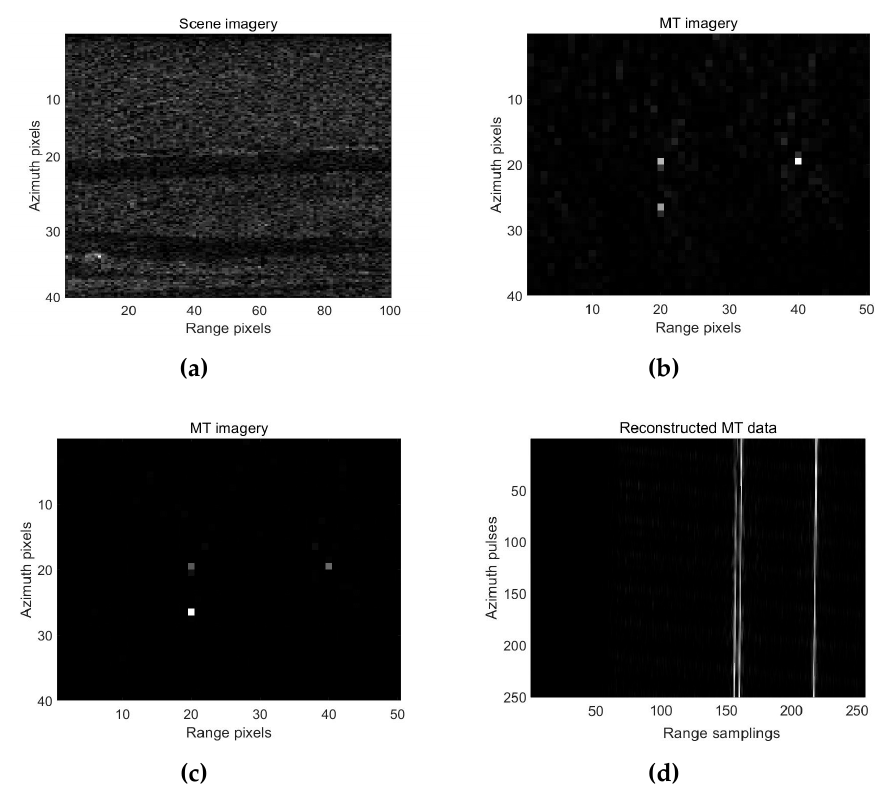
Figure 8. Sparse imaging results derived from the defocused patch in Figure 7c: ( a ) reconstructed static scene imagery, ( b ) reconstructed MT imagery after the first iteration, and ( c , d ) reconstructed MT imagery and radar data.